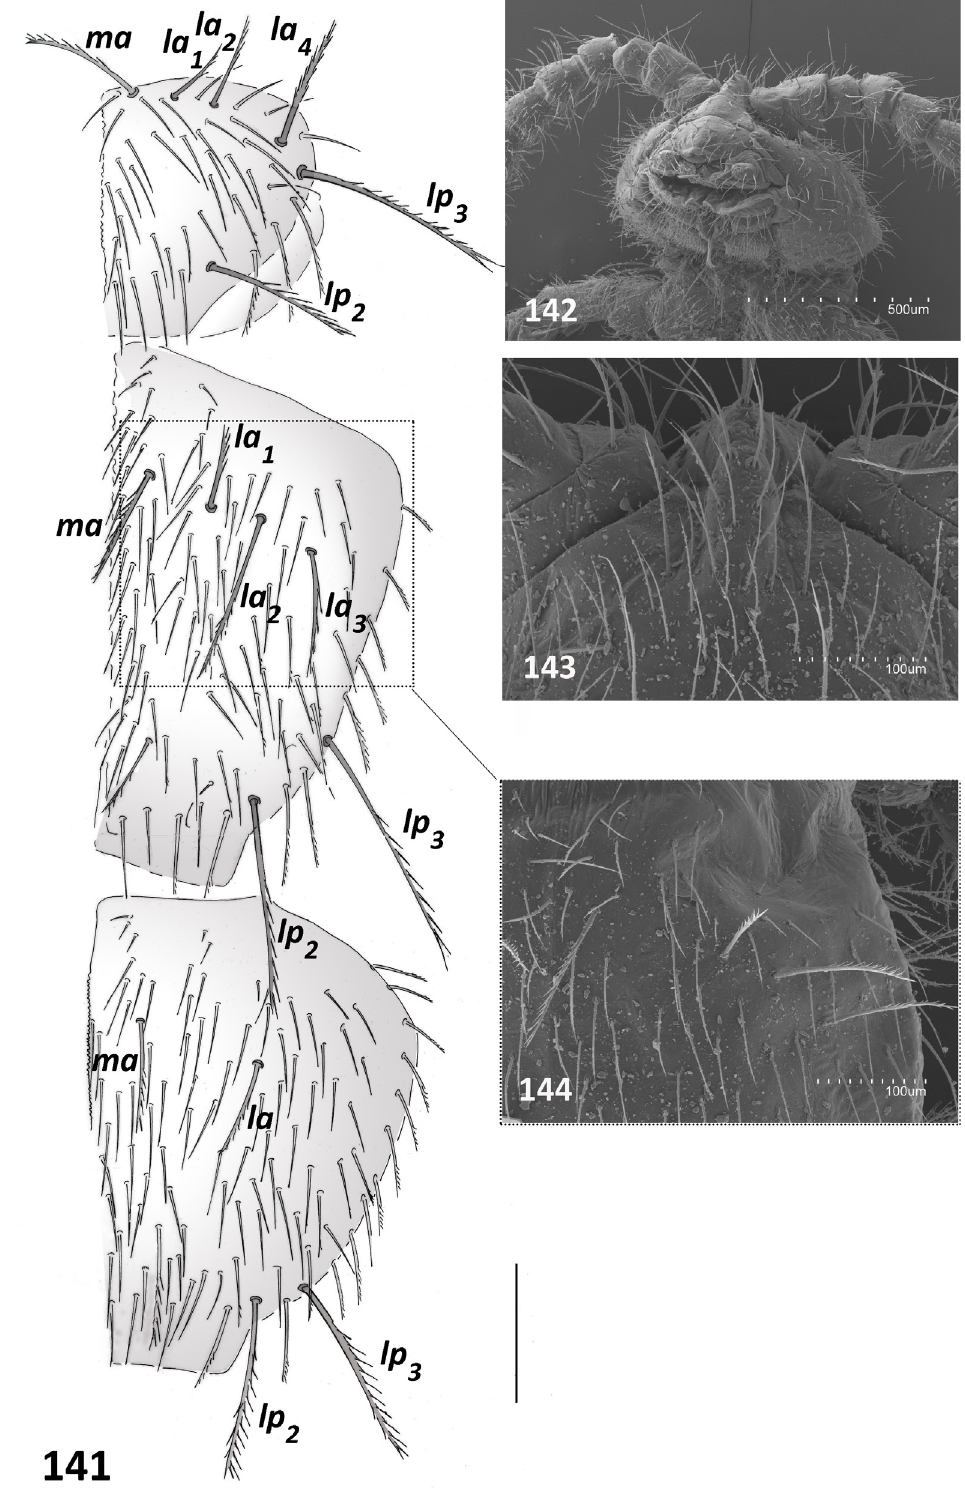
Figs 141–144. Plusiocampa ( Plusiocampa ) strouhali cavicola Vornatscher, 1943, from Odelsteinhöhle, Styria, Austria (Coll. AS). 141 . Pronotum, mesonotum and metanotum, right side ( s = setiform sensillum). 142 . Head, frontal view. 143 . Frontal process. 144 . Detail of mesonotum, right side, with ma and la macrosetae. Scale bar: 141 = 0.2